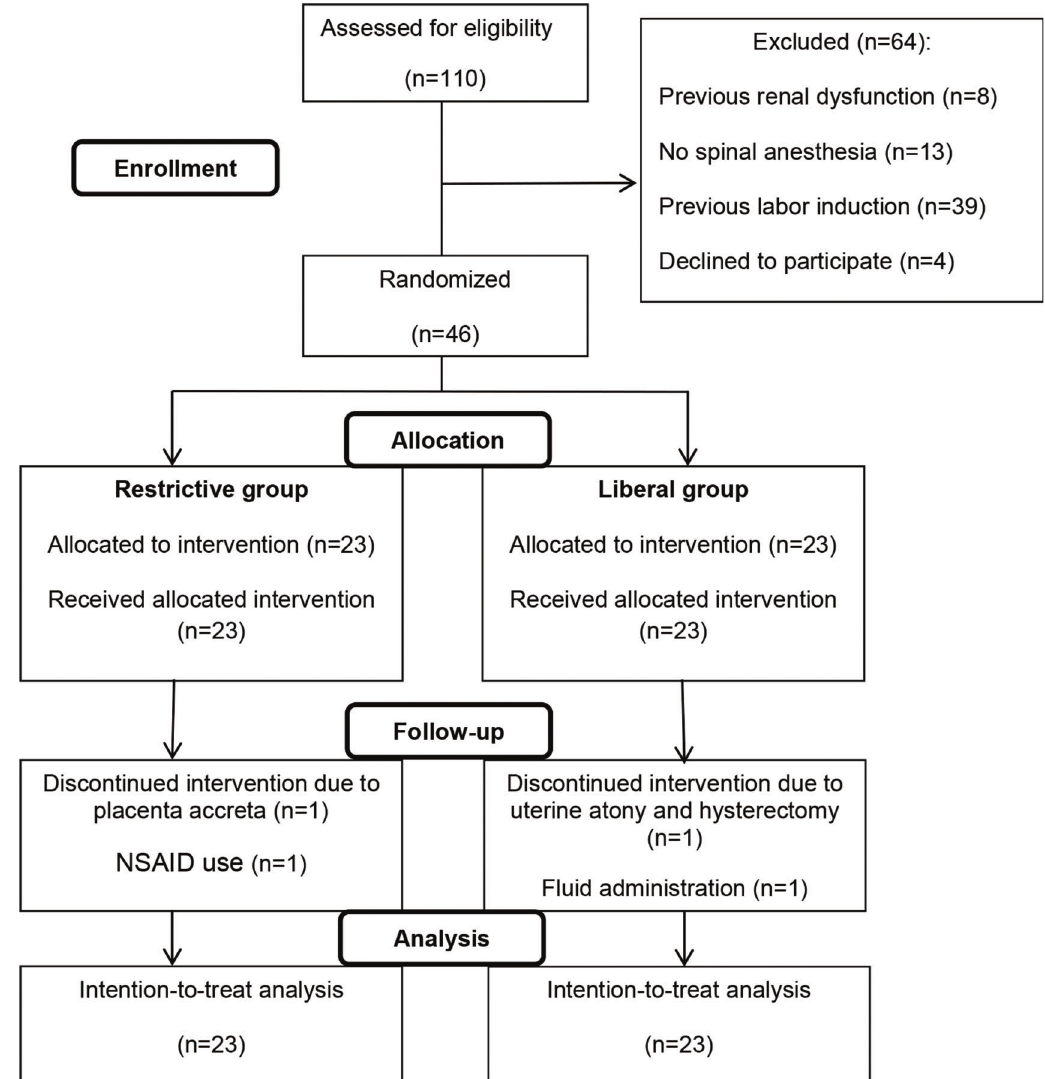
Figure 1 - Flow chart of the study